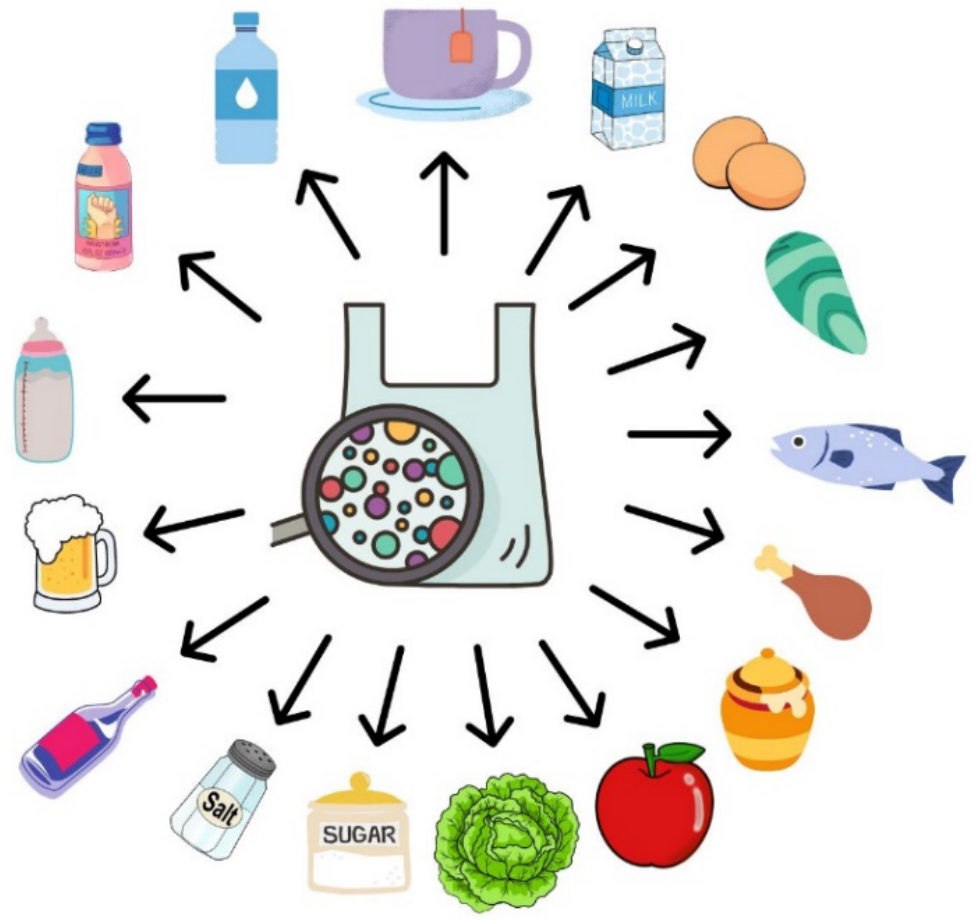
Figure 2. Occurrence of MPs in foods and beverages.